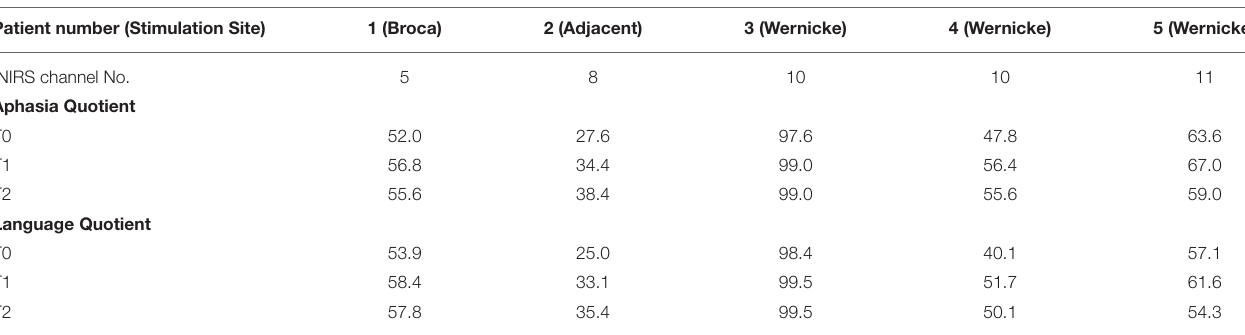
TABLE 2 | Result from K-WAB in five